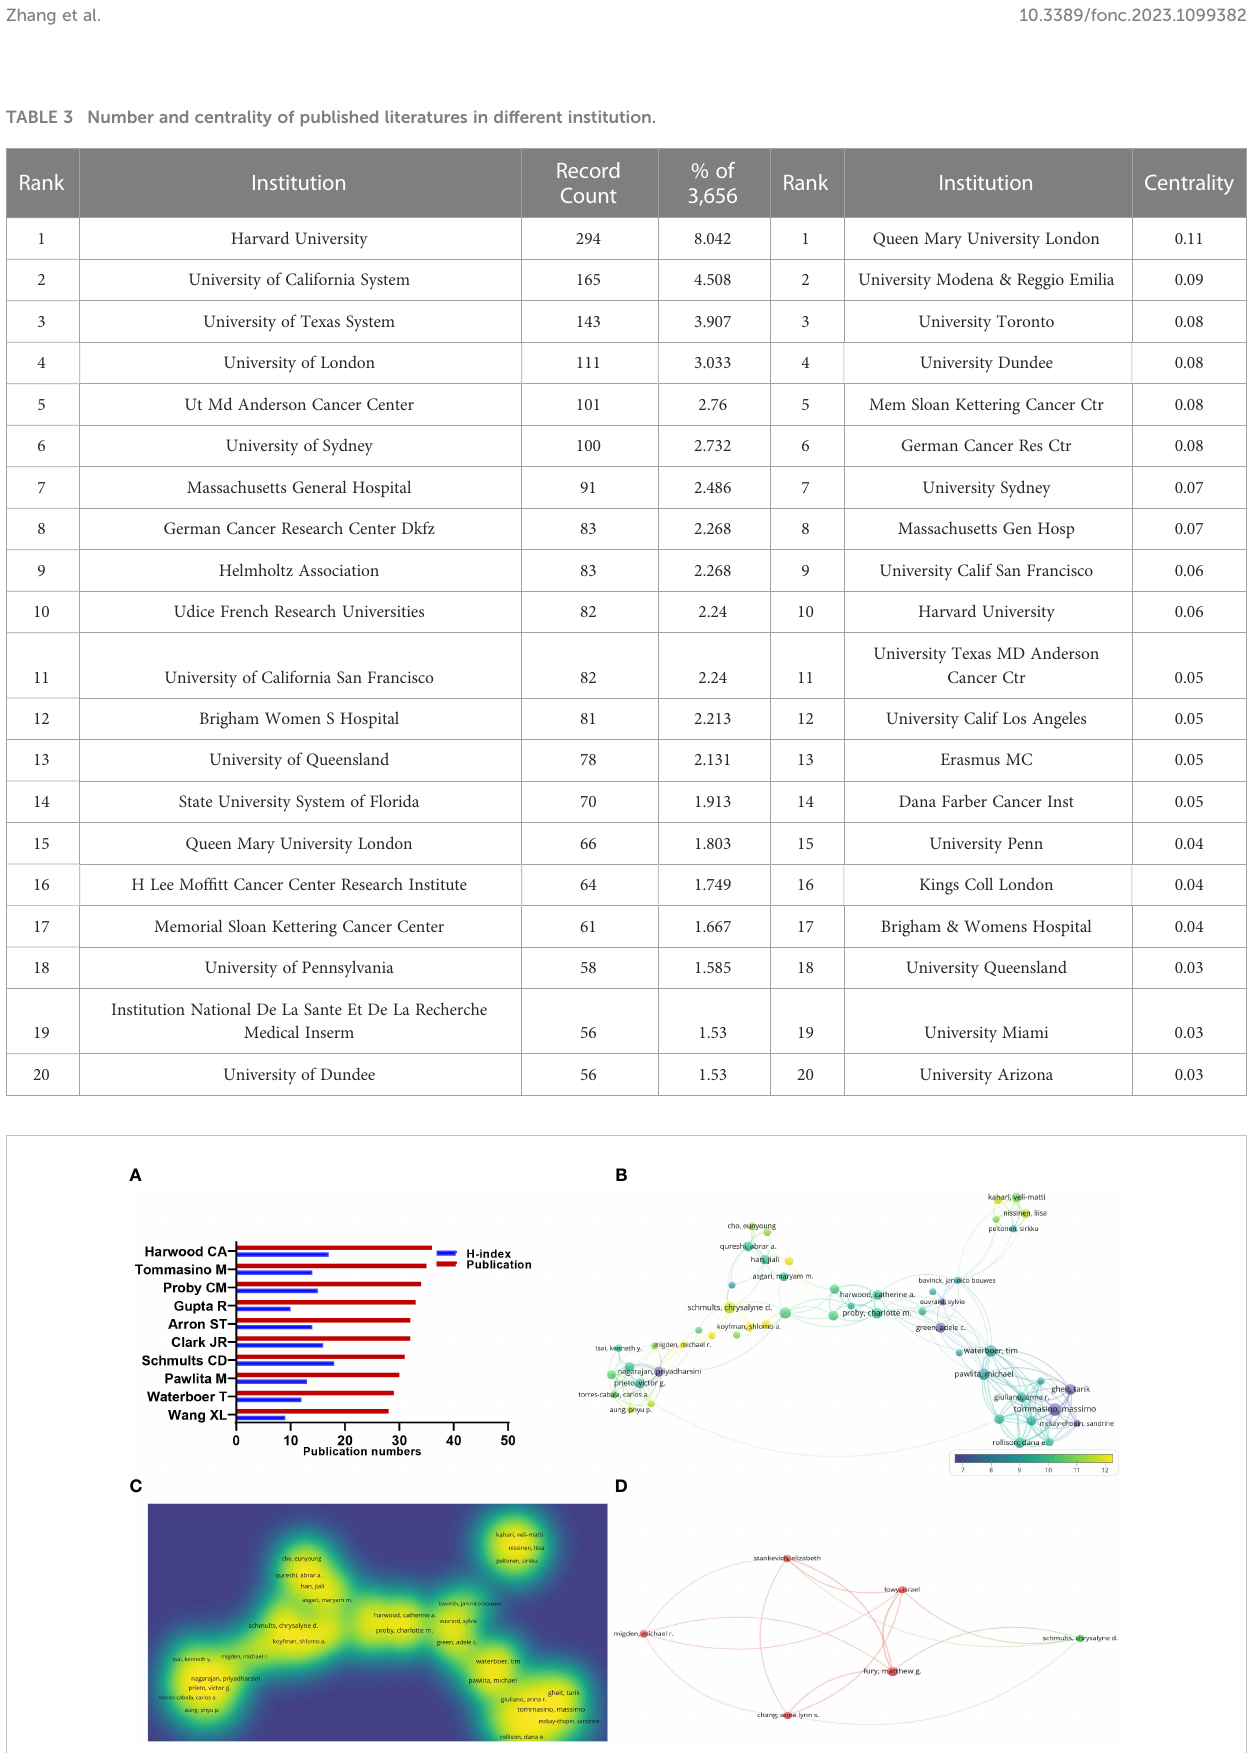
FIGURE 5 The author ’ s published literature. (A) . The number of CSCC articles published by the top 10 authors and the H-index. (B) . CSCC ’ s overlay visualization map of the top authors collaboration. (C) . CSCC ’ s density visualization map of the top authors collaboration. (D) . Excellent author ’ s co-citation analysis in the CSCC procedural death fi